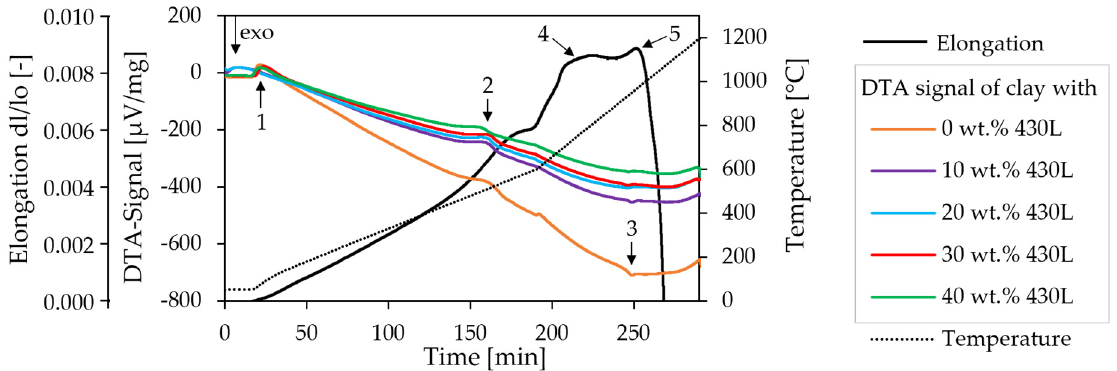
Figure 5. Elongation of clay with 25 wt.% AISI 630 particles and enthalpy change of clay with different amounts of 430 L particles during heating to the sintering temperature of 1200 °C. The heating rate of 300 K/h was increased to 600 K/h at 600 °C.